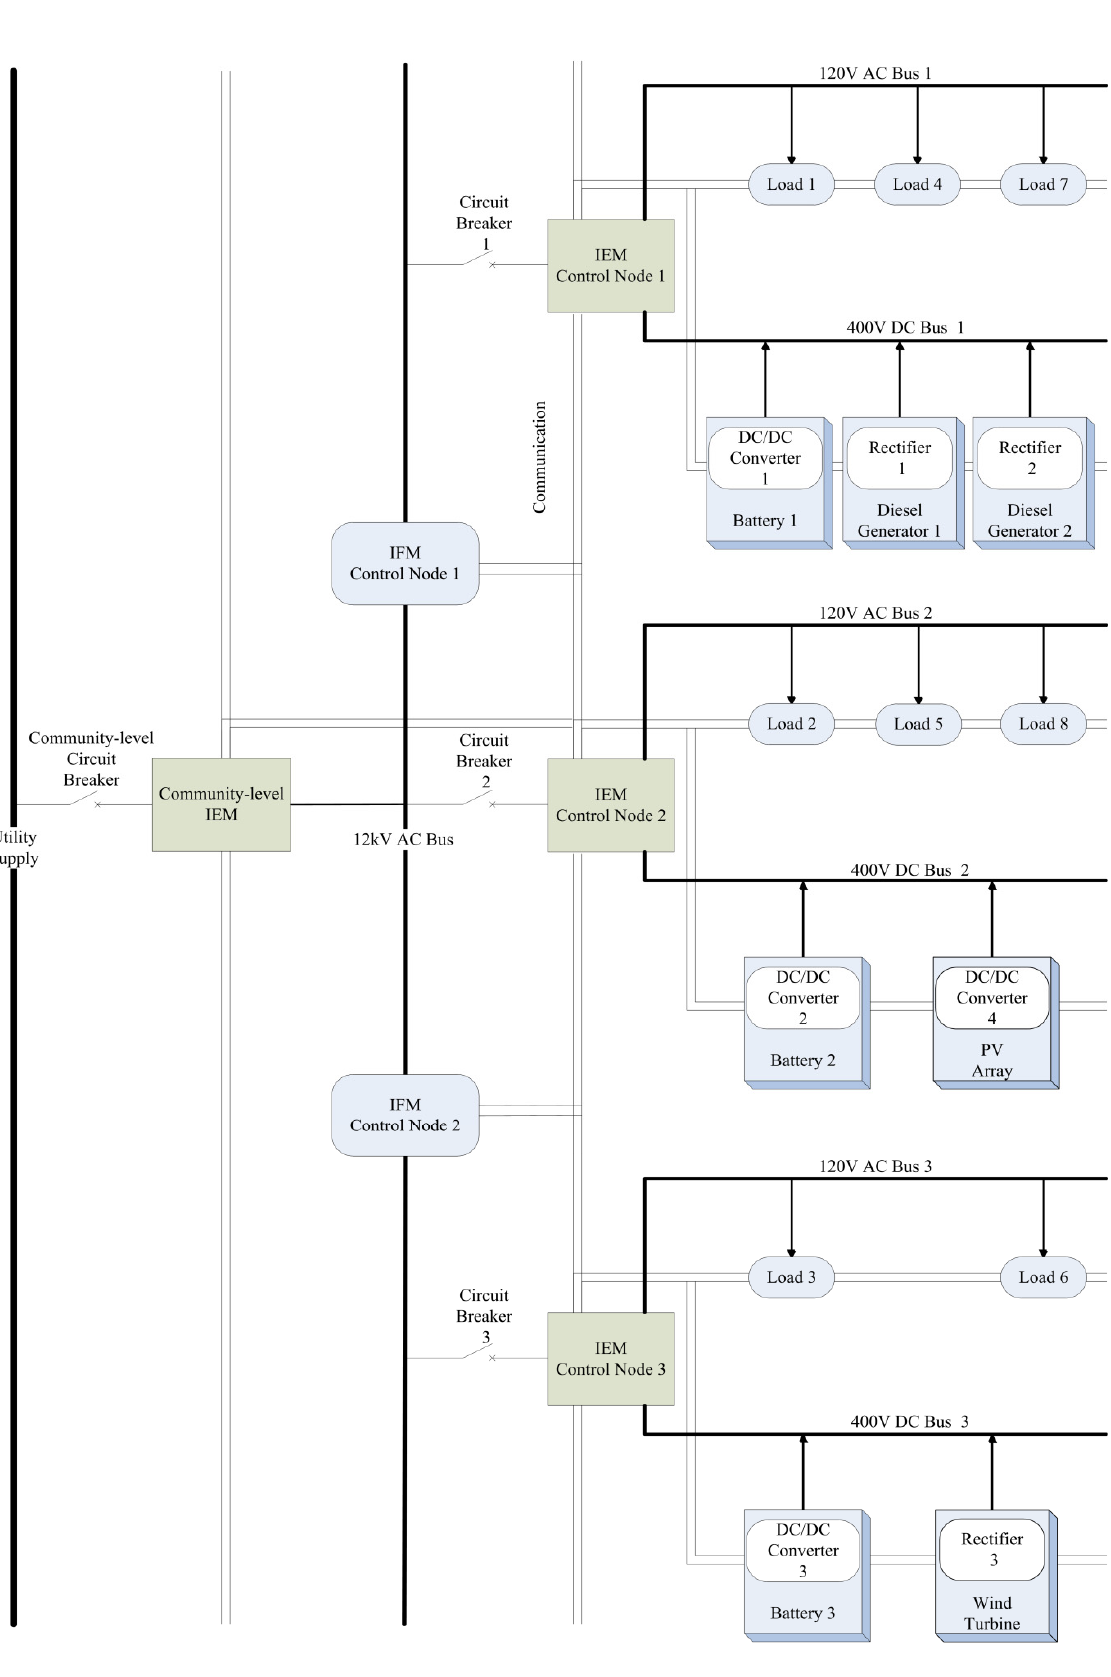
Figure 6. An local framework example of the FREEDM